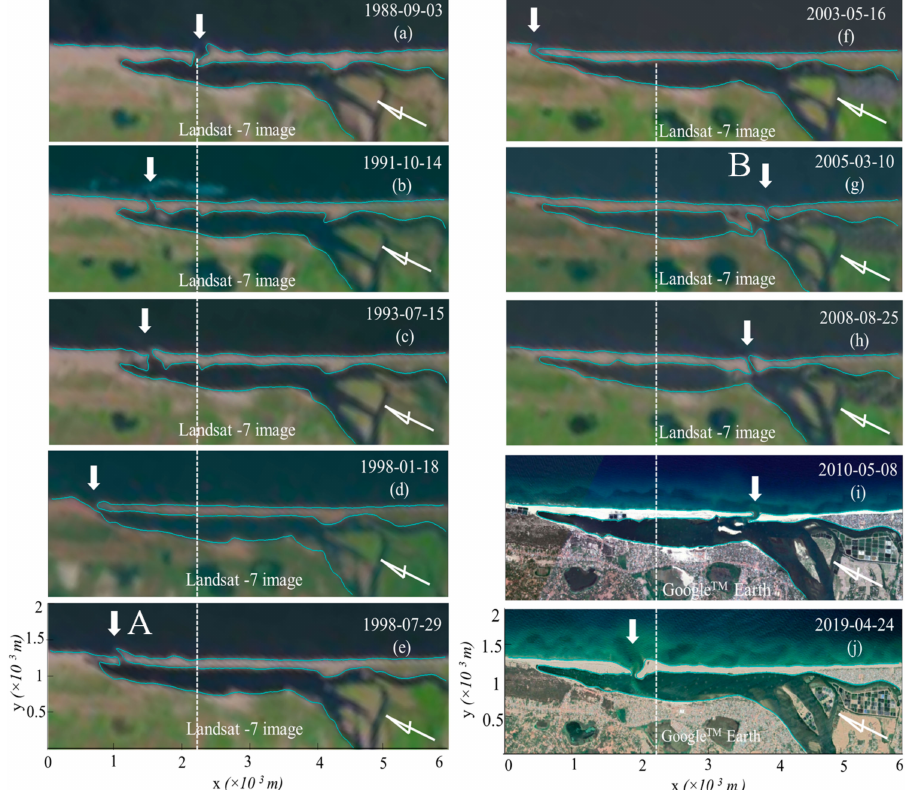
Figure 7. The selected satellite images of the long-term morphological changes at the An Du Inlet, Binh Dinh province from ( a – j ) 3 September 1988 to 24 April